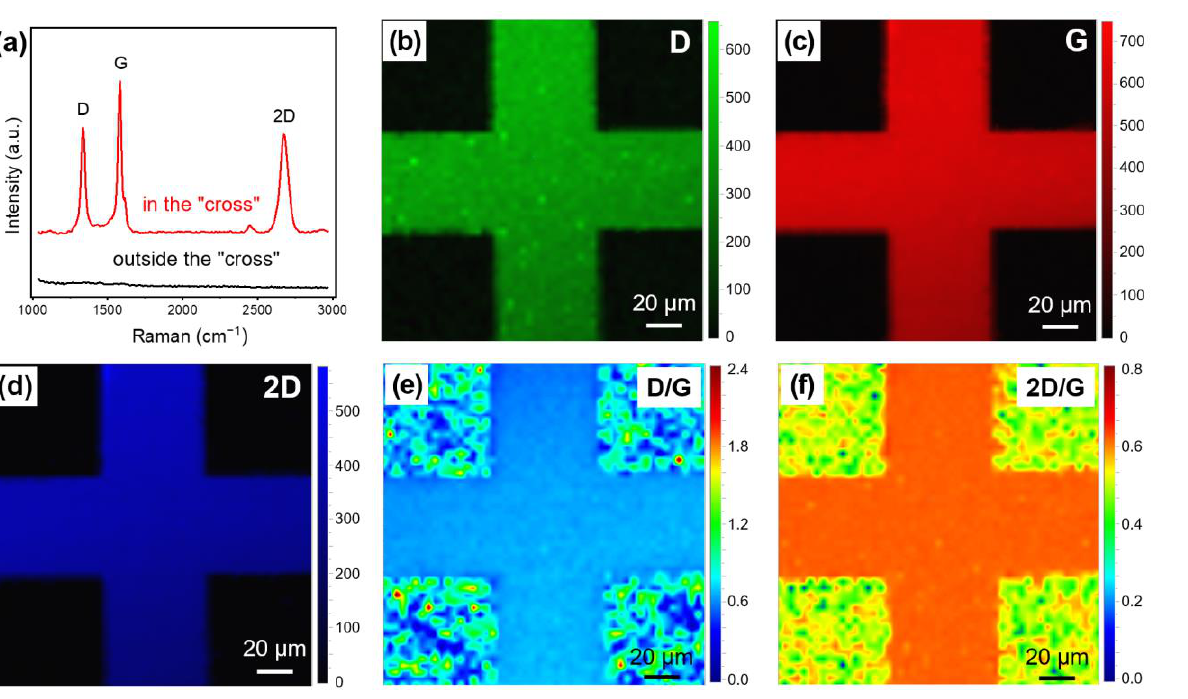
Figure 3. Raman measurements of the patterned VG grown directly on a SiO 2 /Si substrate. ( a ) Ra- man spectra of random points on and outside the patterned VG area. ( b – f ) Raman mapping imag- es of ( b ) I D , ( c ) I G , ( d ) I 2D , ( e ) I D / I G , and ( f ) I 2D / I G . The mapping area is 150 μm × 150 μm, and 2601 da- ta points were used.